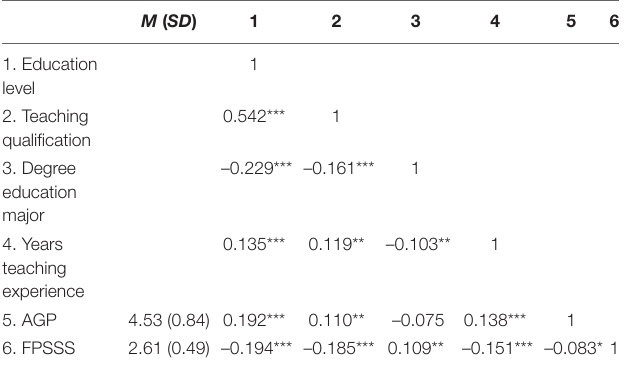
TABLE 3 | Means, standard deviations and intercorrelations of variables in this study.